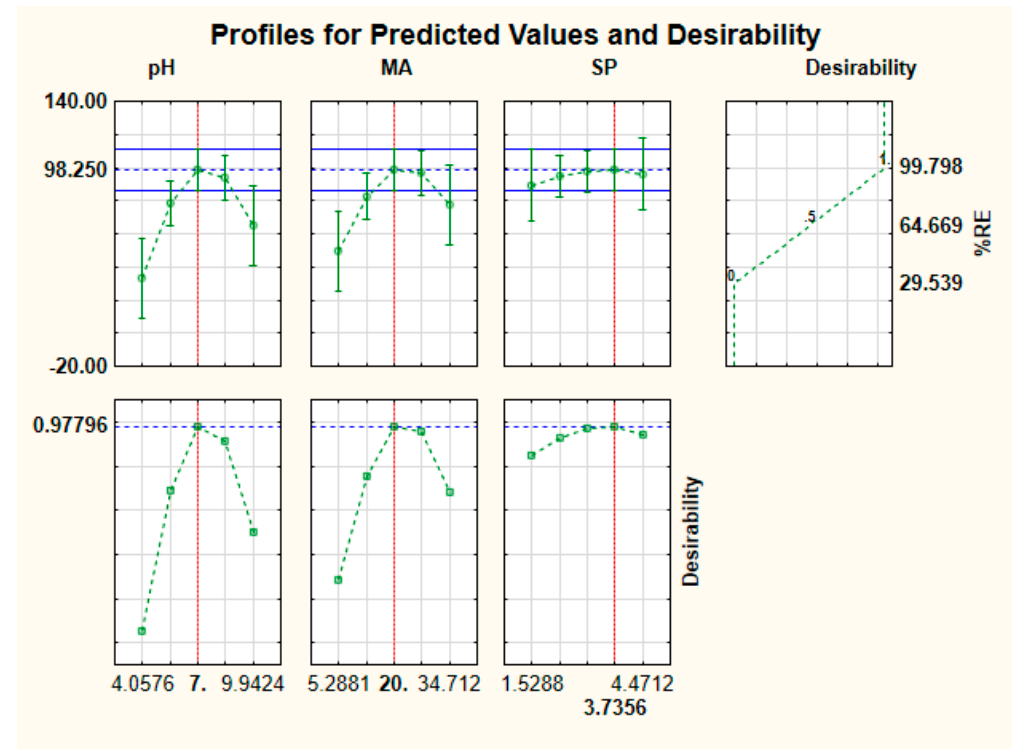
Figure A3. Profiles for predicated values and desirability function for removal of ENRO.